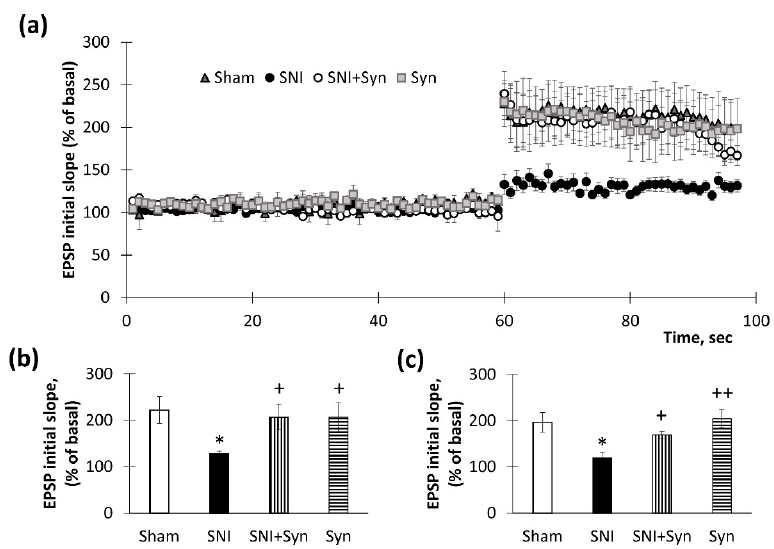
Figure 2. Synaptamide’s effect on SNI-induced long-term potentiation (LTP) inhibition. ( a ) Tetanus-induced LTP in the Schaffer collateral in SNI and synaptamide-treated mouse hippocampus slices. The information is presented as a mean percentage change in the slope of the population excitatory postsynaptic potential (EPSP). ( b ) The averaged initial slope, measured immediately after LTP, %, n = 8 (number of animals per group). ( c ) The averaged initial slope at 35–36 min after LTP, %, mean ± SEM, n = 8 (number slices per group). * p < 0.05 (compared to “Sham”), + p < 0.05, ++ p < 0.01 (compared to “SNI”), Kruskal–Wallis test followed by Dunn’s multiple comparisons tests, * p < 0.05 (compared to “Sham”), + p < 0.05, ++ p < 0.01 (compared to